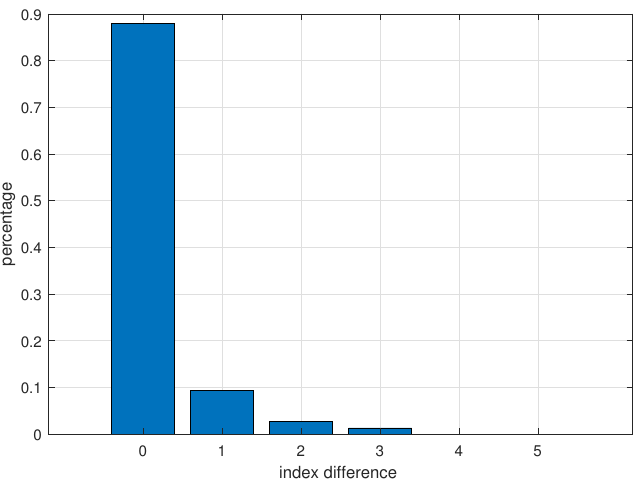
Figure 7. Position difference